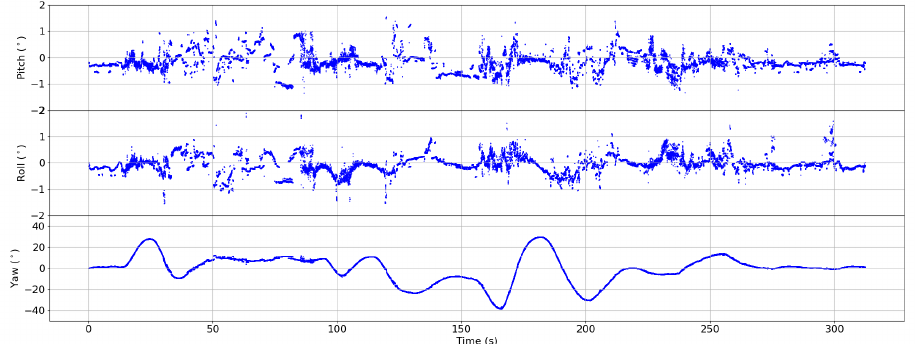
Figure 18. Attitude during trajectory following